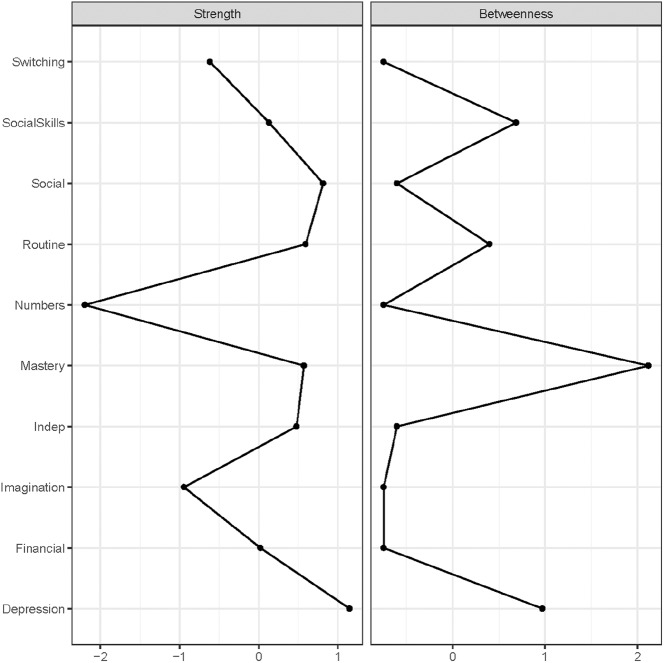
Standardized (i.e. z-scores) centrality indices node strength and betweenness for the autism cohort network in Figure 3.